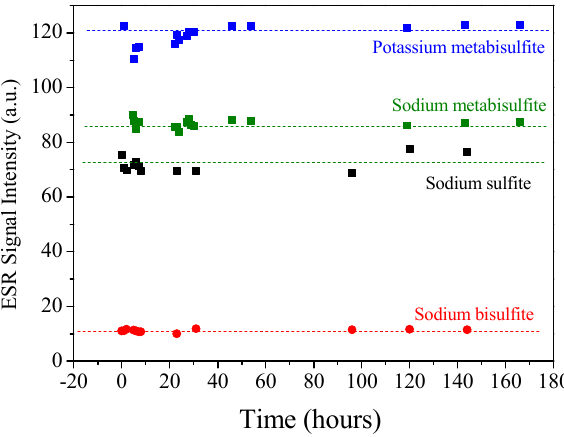
Figure 4. ESR signal amplitude of sample irradiated with a dose of 500 Gy as function of time after irradiation, showing the stability of signals during this period.